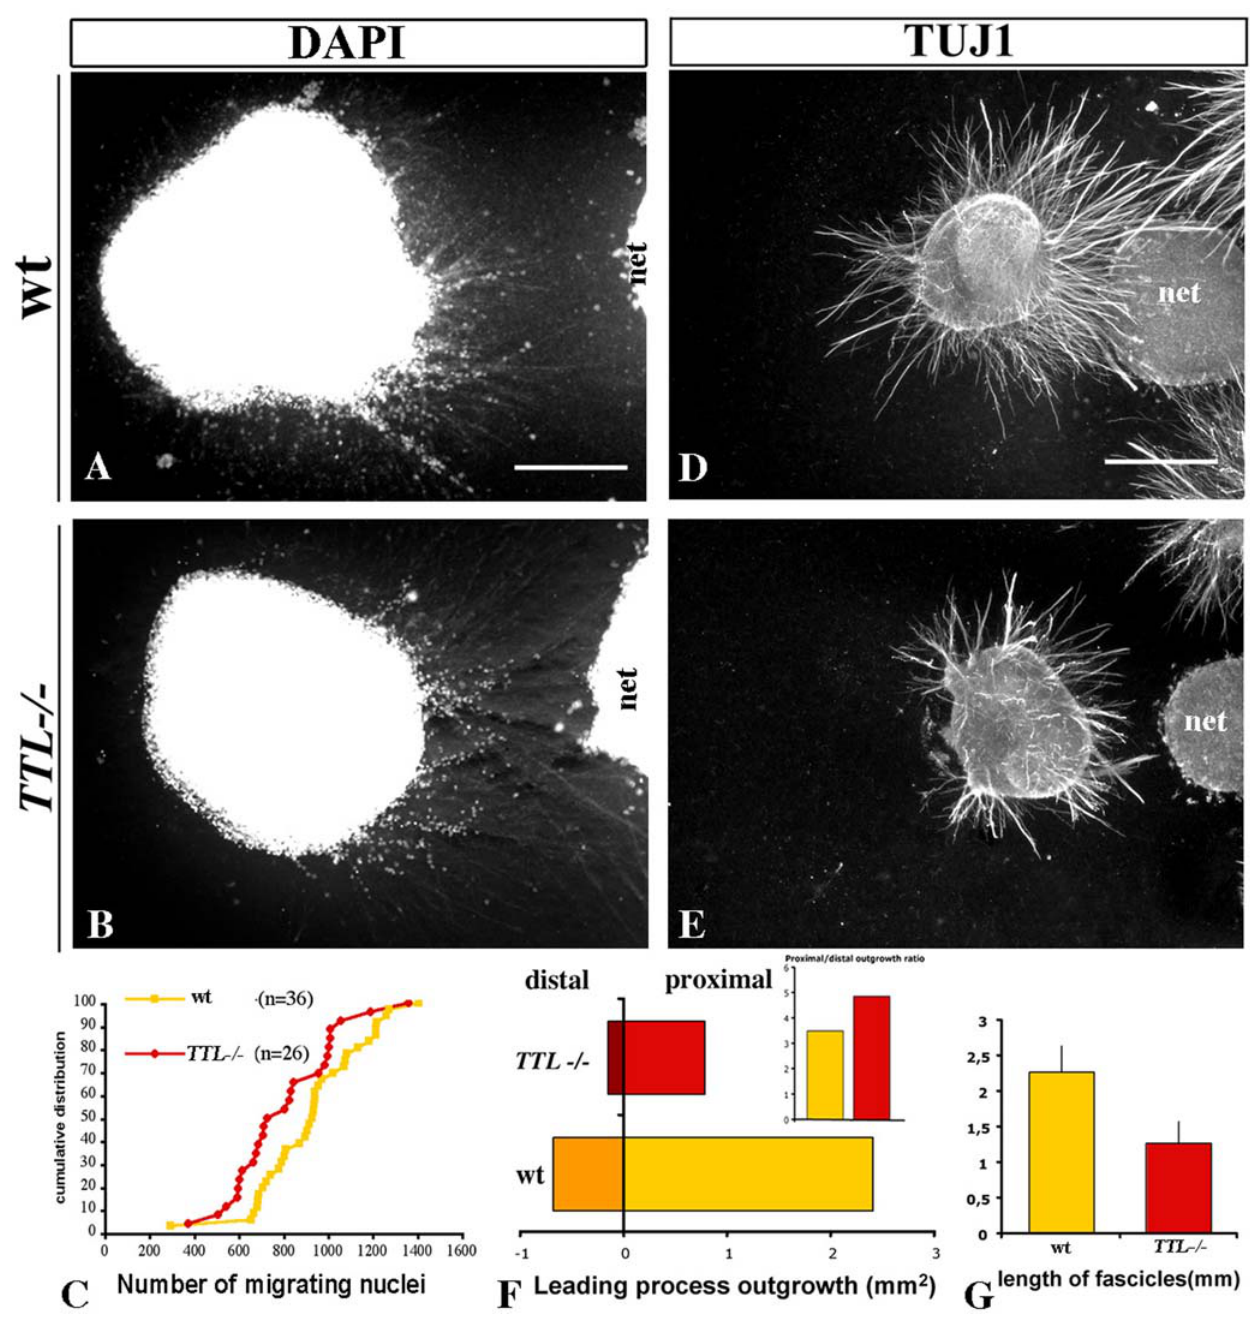
Figure 4. Analysis of axon outgrowth from TTL 2 / 2 explants toward a local source of Netrin-1 compared to wt explants. E12.5 rhombic lip explants containing PCN neurons were faced with Netrin-1-secreting cells (net1) and cultured for 3 days. Nucleokinesis and axon outgrowth were analyzed with DAPI and TUJ1 antibody stainings respectively. (A, B) Nuclear migration from wt and TTL 2 / 2 explants toward Netrin-1 secreting cells did not show any difference. (C) Cumulative distribution quantification of nucleokinesis from wt and TTL 2 / 2 explants. (D, E) Axon outgrowth in wt explants (D) was more developed than in TTL 2 / 2 explants (E). (F) Bar graphs showing total axon outgrowth toward (proximal) and away (distal) from the Netrin-1 source were obtained upon threshold quantifications. The proximal versus distal ratio outgrowth was not altered in TTL 2 / 2 explants, but the total axon outgrowth was reduced about 3 times. (G) Bar graph showing quantification of the length of axon fascicles growing out of the rhombic lips explants measured for 20 fascicles of each explant from wt and TTL 2 / 2 embryos. n=36 explants for wt and n=26 for TTL 2 / 2 for every quantification. * P , 0,05 . Scale bars: 250 m m in A (for A, B), 500 m m in D (for D, E). doi:10.1371/journal.pone.0005405.g004 the distal part of axons showed a more complex morphology in TTL 2 / 2 neurons due to extensive branching compared to wt ones, that never branched (see wt and TTL 2 / 2 Movie S1 and when they reached the tip of the fascicles. We have observed that Movie S2 respectively in supplementary material, and Fig. 5C and